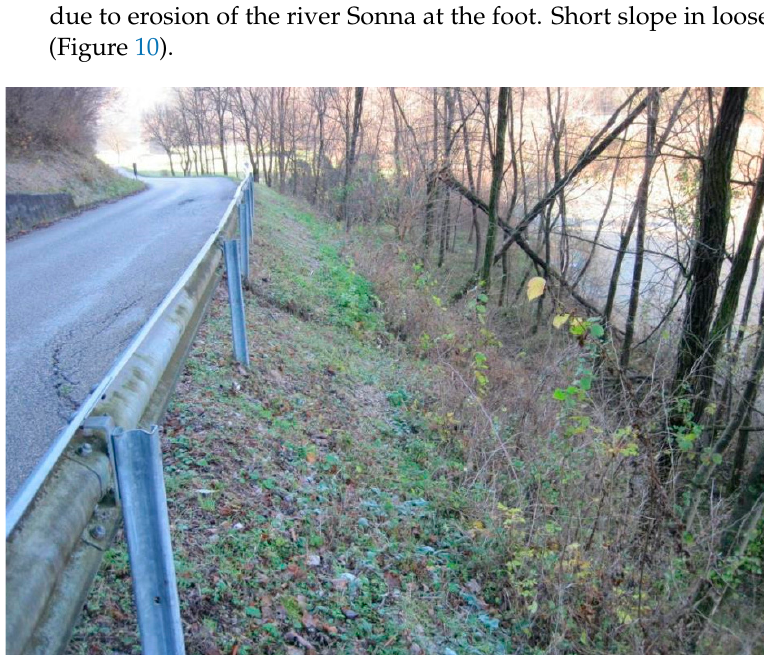
Figure 10. Landslide photograph code 025021_07c.